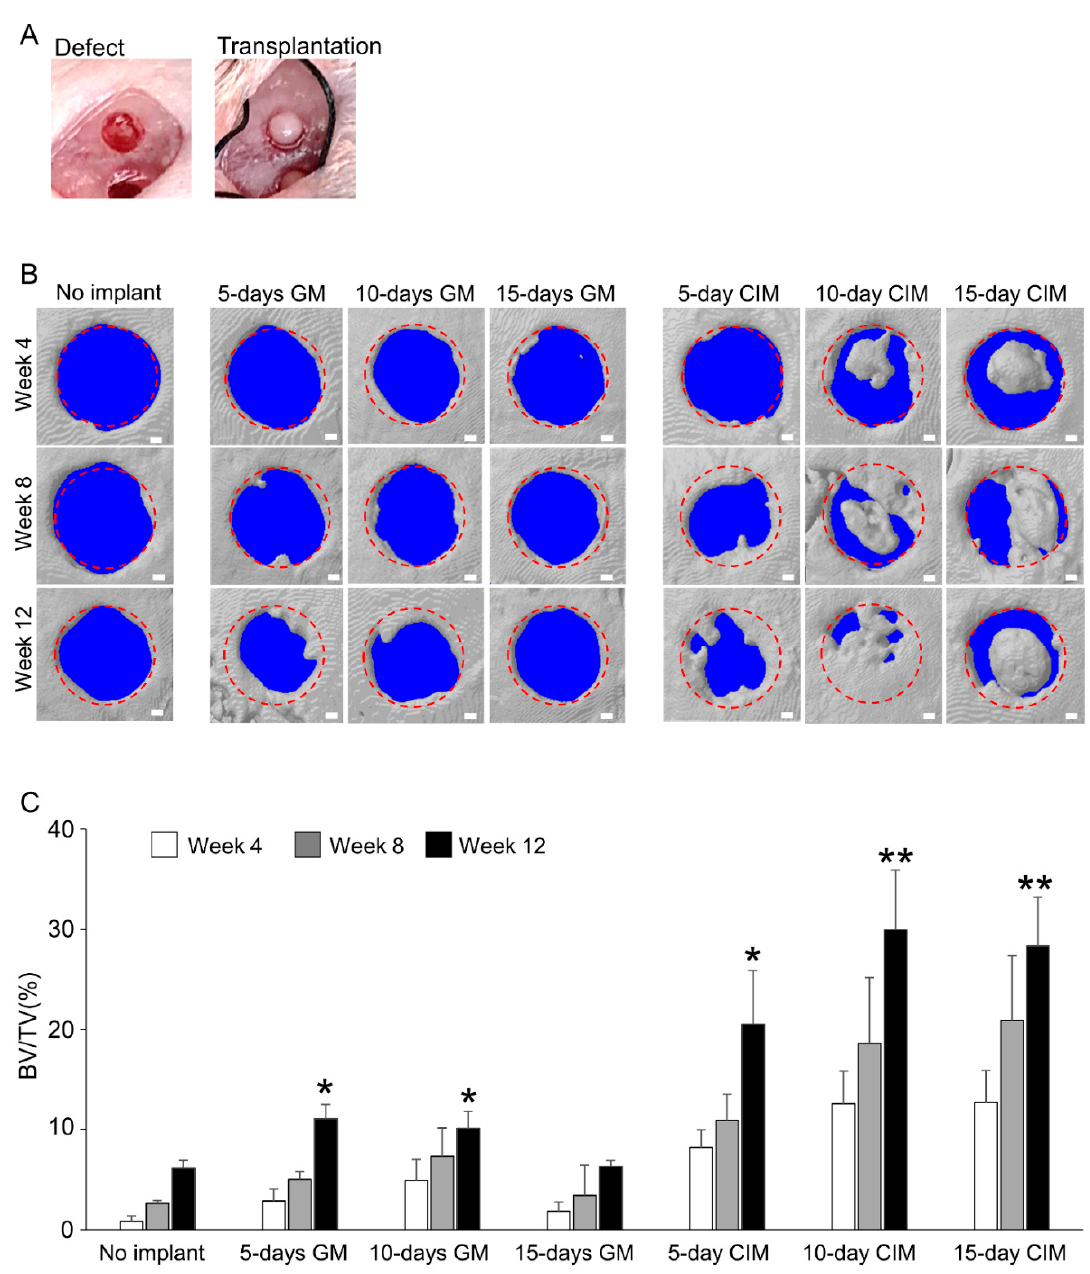
Figure 3. C-MSCs generated with XF-CIM expressed hypertrophic chondrocytes marker genes. ( A ) C-MSCs cultured in XF-GM or XF-CIM for 5, 10, or 15 days were directly transplanted into a SCID mouse cranial defect 1.6 mm in diameter. No implant group was set as a control ( n = 6/each group). ( B ) Representative micro-CT images of six samples at 4, 8, and 12 weeks surgery. Bar = 250 μ m. ( C ) Ratio of the segmented bone volume (BV) to the total volume (TV) of the defect region after 4, 8, and 12 weeks of surgery. Values are mean ± S.D. of six mice per group, * p < 0.05, ** p < 0.01, and differ significantly from the no implant group (ANOVA). 5-day GM: transplantation of C-MSCs cultured in XF-GM for 5 days; 10-day GM: transplantation of C-MSCs cultured in XF-GM for 10 days; 15-day GM: transplantation of C-MSCs cultured in XF-GM for 15 days; 5-day CIM: transplantation of C-MSCs cultured in XF-CIM for 5 days; 10-day CIM: transplantation of C-MSCs cultured in XF-CIM for 10 days; 15-day CIM: transplantation of C-MSCs cultured in XF-CIM for 15